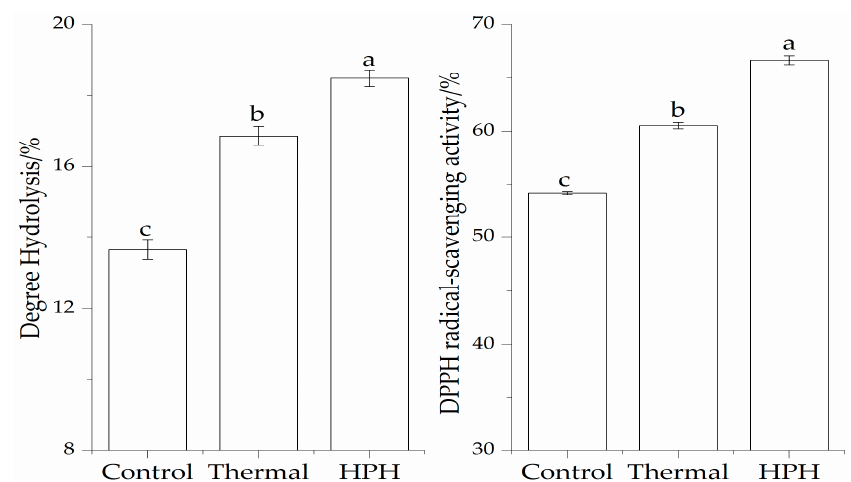
Figure 1. Effect of pretreatment on enzymatic hydrolysis and DPPH radical-scavenging activity of the SPI hydrolysates. Values with different letters in the same column are significantly different according to Duncan’s multiple range test ( p < 0.05).